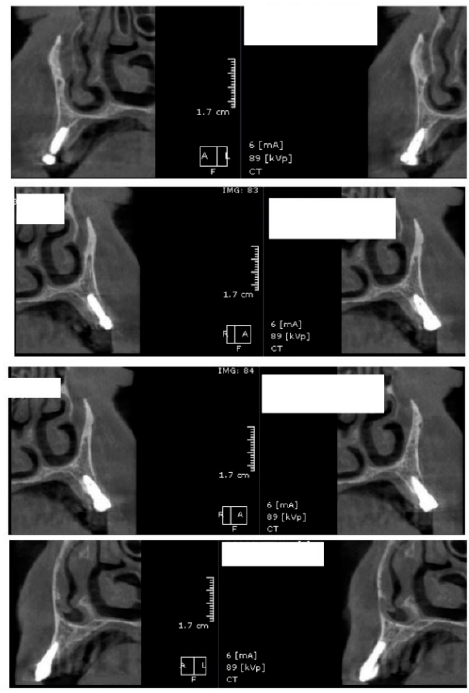
Figure 10. Random CBCT sections with pulse electromagnetic healing caps in position.